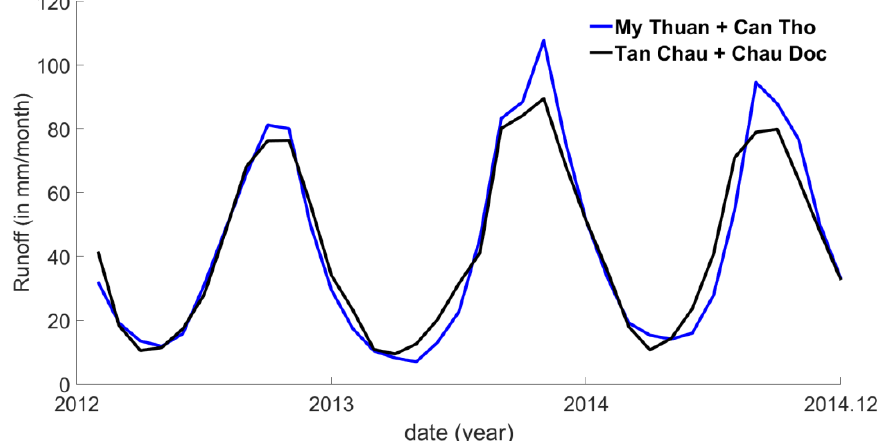
Figure 2. Runo ff generated from the sum of My Thuan and Can Tho stations, and the sum of Tan Chau Figure 2. Runoff generated from the sum of My Thuan and Can Tho stations, and the sum of Tan and Chau Doc Chau and Chau Doc stations.